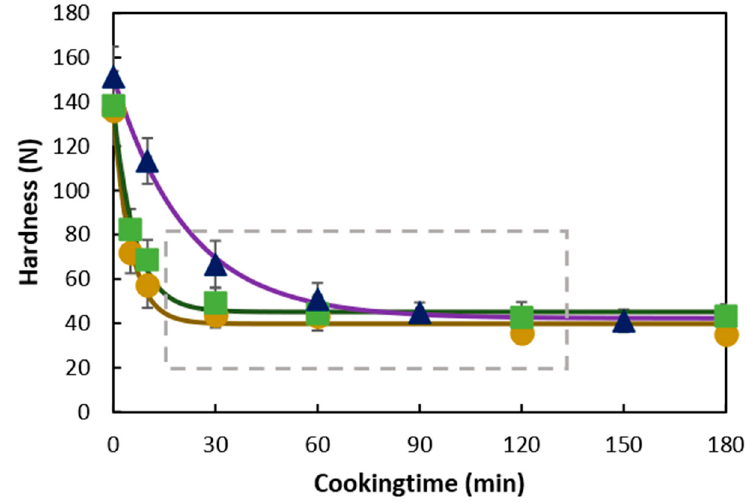
Figure 1. Hardness profile for chickpea ( • ), pea ( (cid:4) ), or black bean ( (cid:78) ) whole pulse seeds cooked in demineralized water at 95 ◦ C. Markers represent the average hardness (N) value of 25 seeds, and error bars represent the standard deviation of the measurements. Lines show fitted hardness values of the first-order fractional conversion model (Equation (4)). The grey rectangle highlights the samples selected for further in vitro digestion